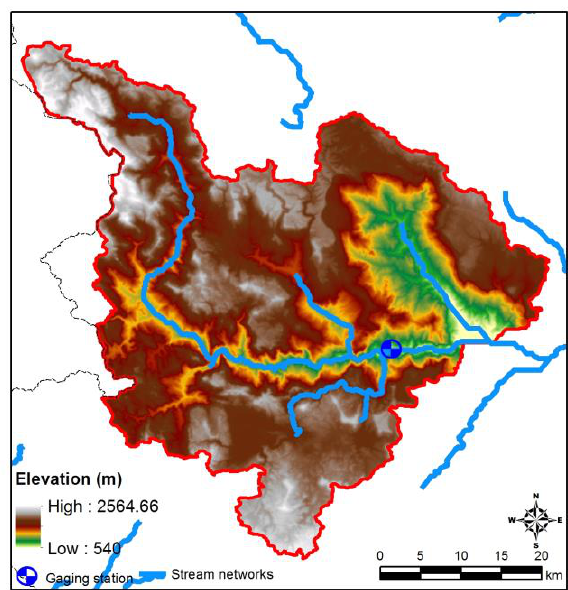
Figure 4. Digital elevation model of the study area Climate